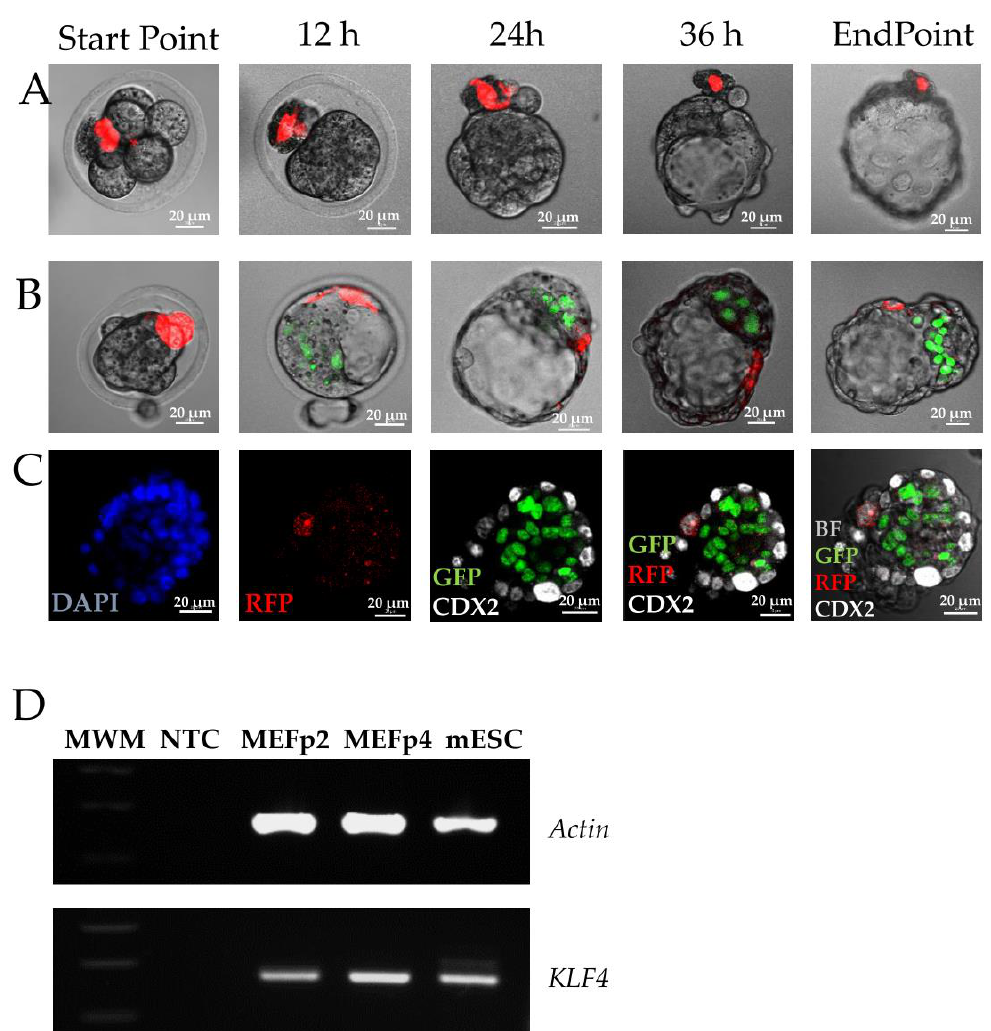
Figure 1. Development to the blastocyst of chimeric embryos carrying MEF cell-expressing RFP (red). ( A ) Chimeric embryo with MEF cell-expressing RFP (red) being eliminated from the embryo after blastomere puncturing; ( B ) development of chimeric embryo to blastocyst with MEF cell-expressing RFP (red), integrated with the embryo without blastomere puncturing; ( C ) immunofluorescent staining of blastocyst with MEF cell expressing RFP (red), integrated with the embryo without blastomere puncturing; ( D ) RT-PCR analysis of KLF4 expression in MEF cells at passage 2 (p2) and 4 (p4), as compared to mouse embryonic stem cells. Materials and methods are described in [2]. Table 1. The presence of reprogrammed MEF cells in blastocysts with and without destroyed blastomeres. Number of